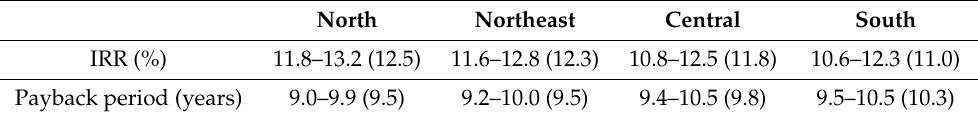
Table A10. IRR and payback period by region for MGS customers under a buyback rate below